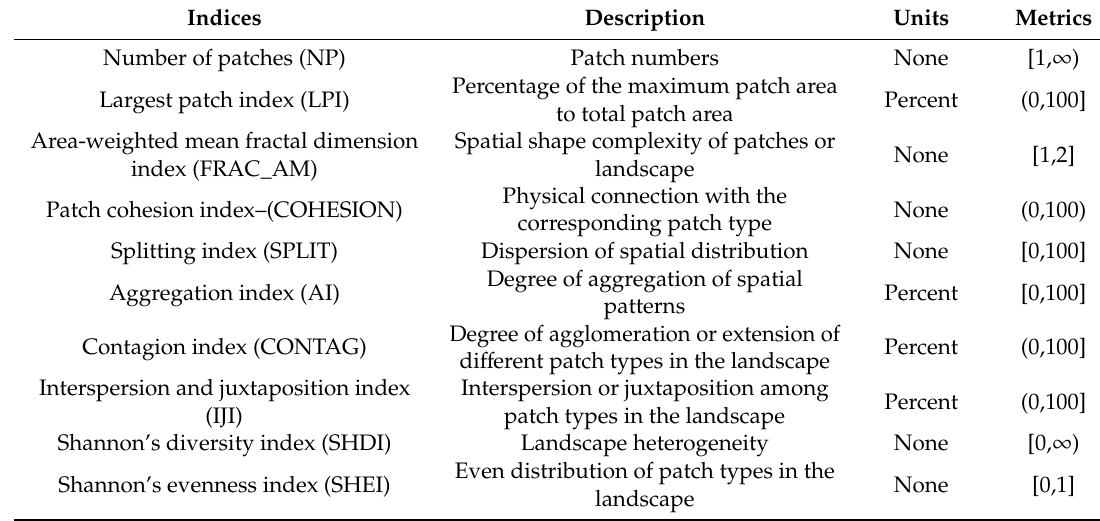
Table 1. Class- and landscape-level indices.